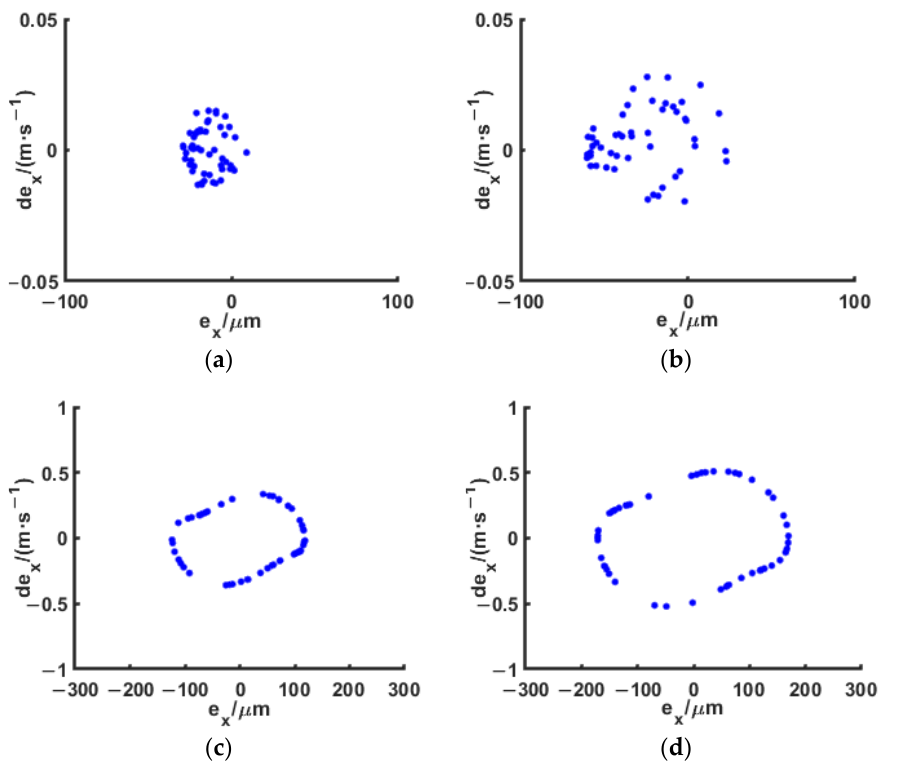
Figure 13. Poincare mapping at different clearance sizes. ( a ) 𝑟 = 0.03 . ( b ) 𝑟 = 0.06 . ( c ) 𝑟 = 0.09 . ( d ) 𝑟 = 0.12 .